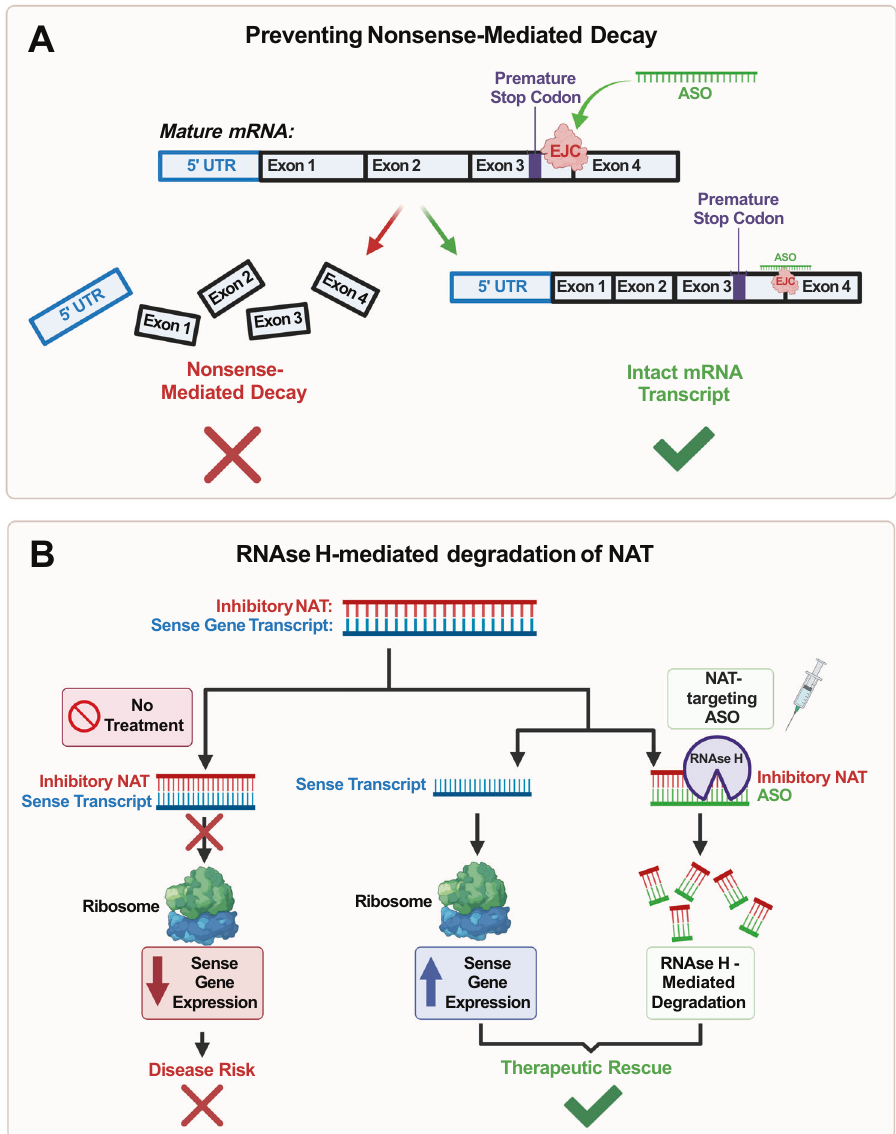
Fig. 5 Diagram of antisense oligonucleotide (ASO) mechanisms pertaining to mRNA transcript degradation. A ASOs prevent the nonsense-mediated decay (NMD) of an mRNA transcript through hybridization. By targeting the exon-junction complex (EJC) region downstream of a transcript ’ s premature termination codons (PTC), the ASOs increase the stability of the transcript. This prevents NMD and increases the translational expression of the target gene; B ASOs can induce RNAse H-mediated degradation of a natural antisense transcript (NAT) to relieve inhibition of the sense mRNA transcript through hybridization. The RNAse H endonuclease enzyme will recognize and cleave the ASO-NAT duplex, thus allowing for unsuppressed translation of the respective sense gene. Paternal allele activation of UBE3A via a UBE3A- AS-Targeting ASO (most right column) is a speci fi c example of this mechanism used to treat Angelman